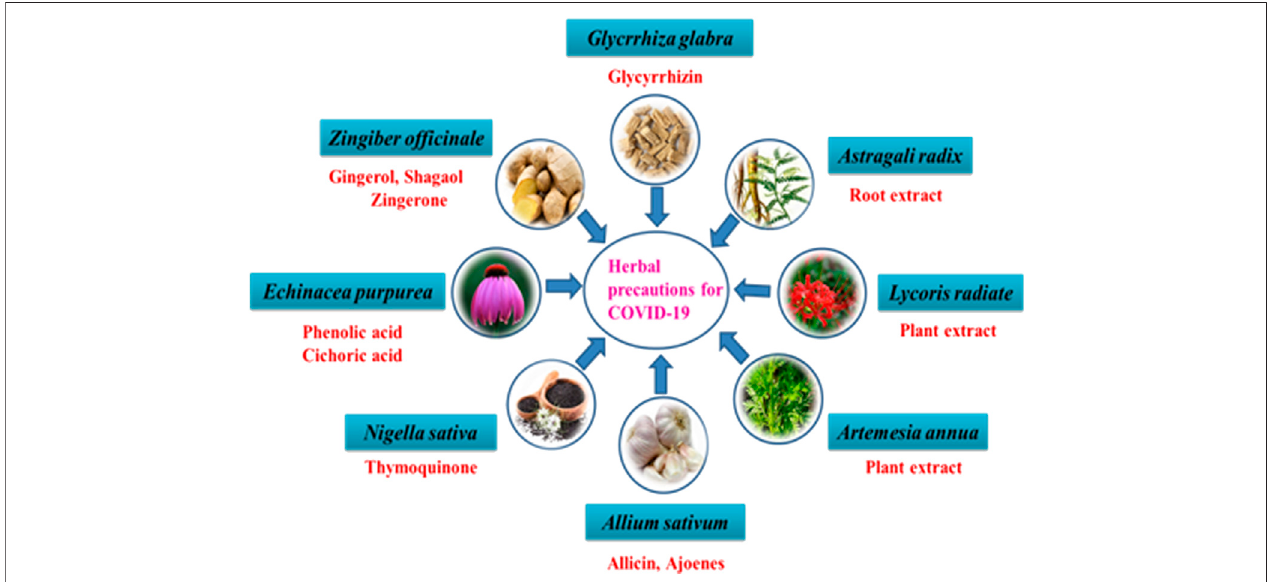
FIGURE 6 | Herbal immunomodulatory remedies for the treatment of